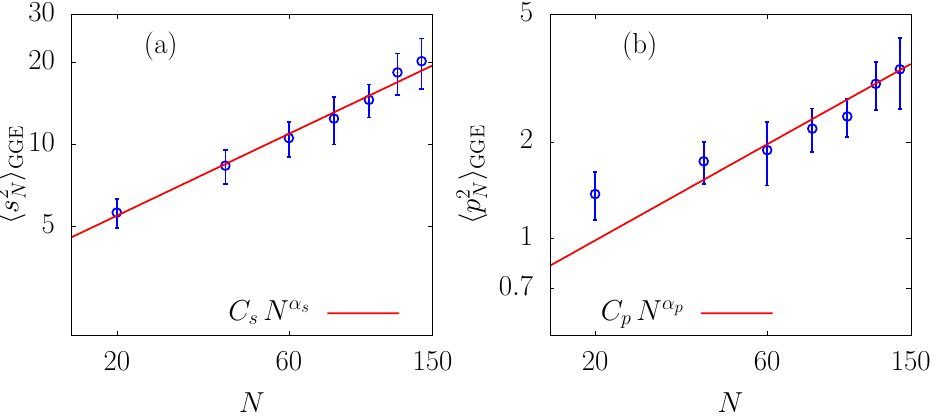
= 0.8 J and 0 0 = ( JJ ) 1 / 2 . (a) 〈 s 2 〉 0 0 GGE N = 0.62 ± 0.03. (b) 〈 p 2 〉 s GGE N = 0.62 (in red) which describes N α s with α p s = 0.4 ± 0.05 which is not consistent p